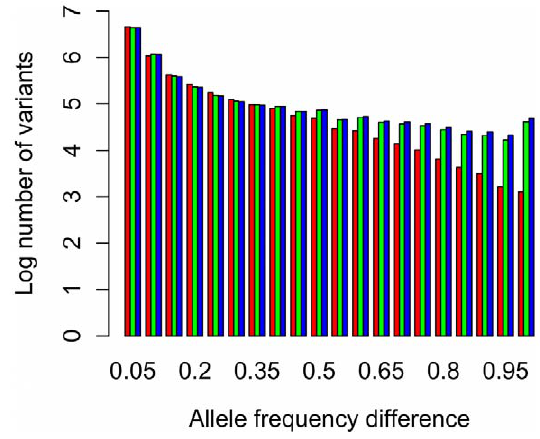
Figure 2. Frequency histogram of differentiation between populations, on a log scale. Pair-wise comparisons are shown between the two control populations, and between the two independent comparisons of a large- and small-selected population. Red=control population 1 versus control population 2; green=large population 1 versus small population 1; blue=large population 2 versus